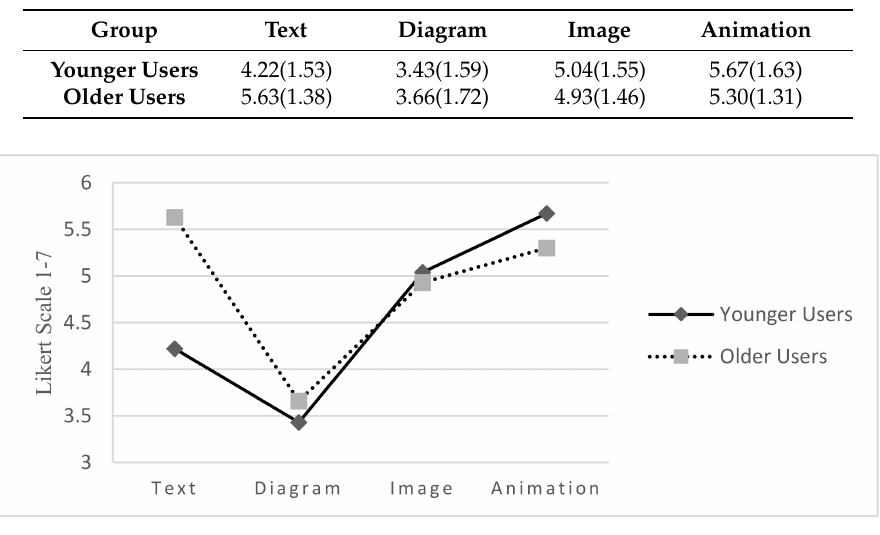
Figure 14. Comparison of overall reactions to the four interfaces.